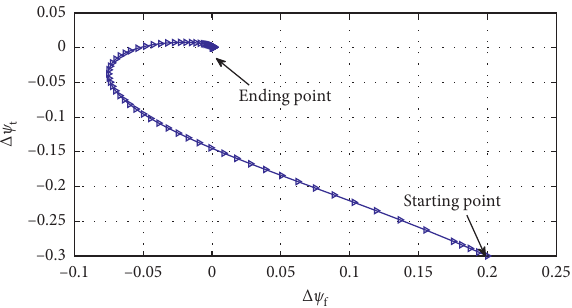
Figure 3: 2D plot of Δ ψ